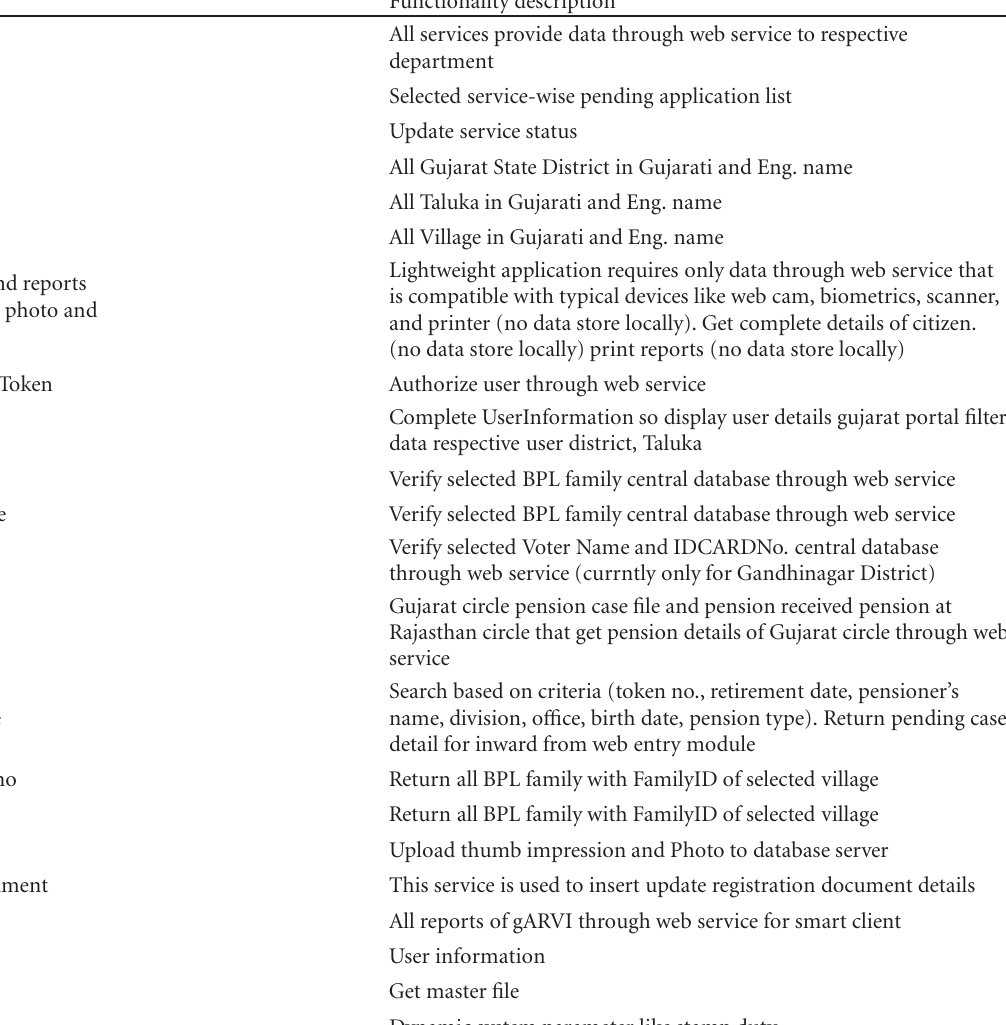
Table 1: Cloud web services functional